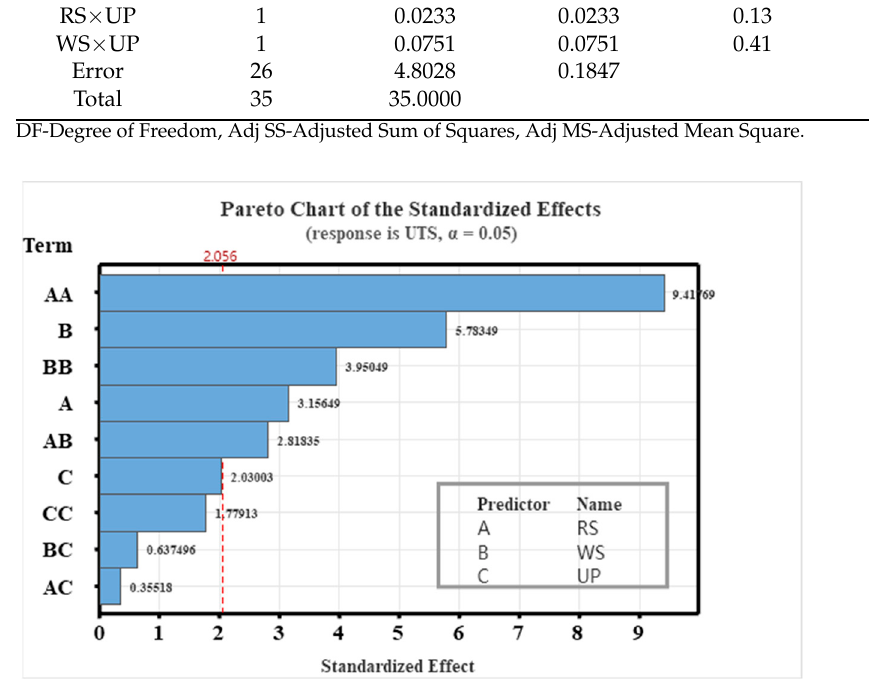
Figure 8. Pareto chart for ultimate tensile strength